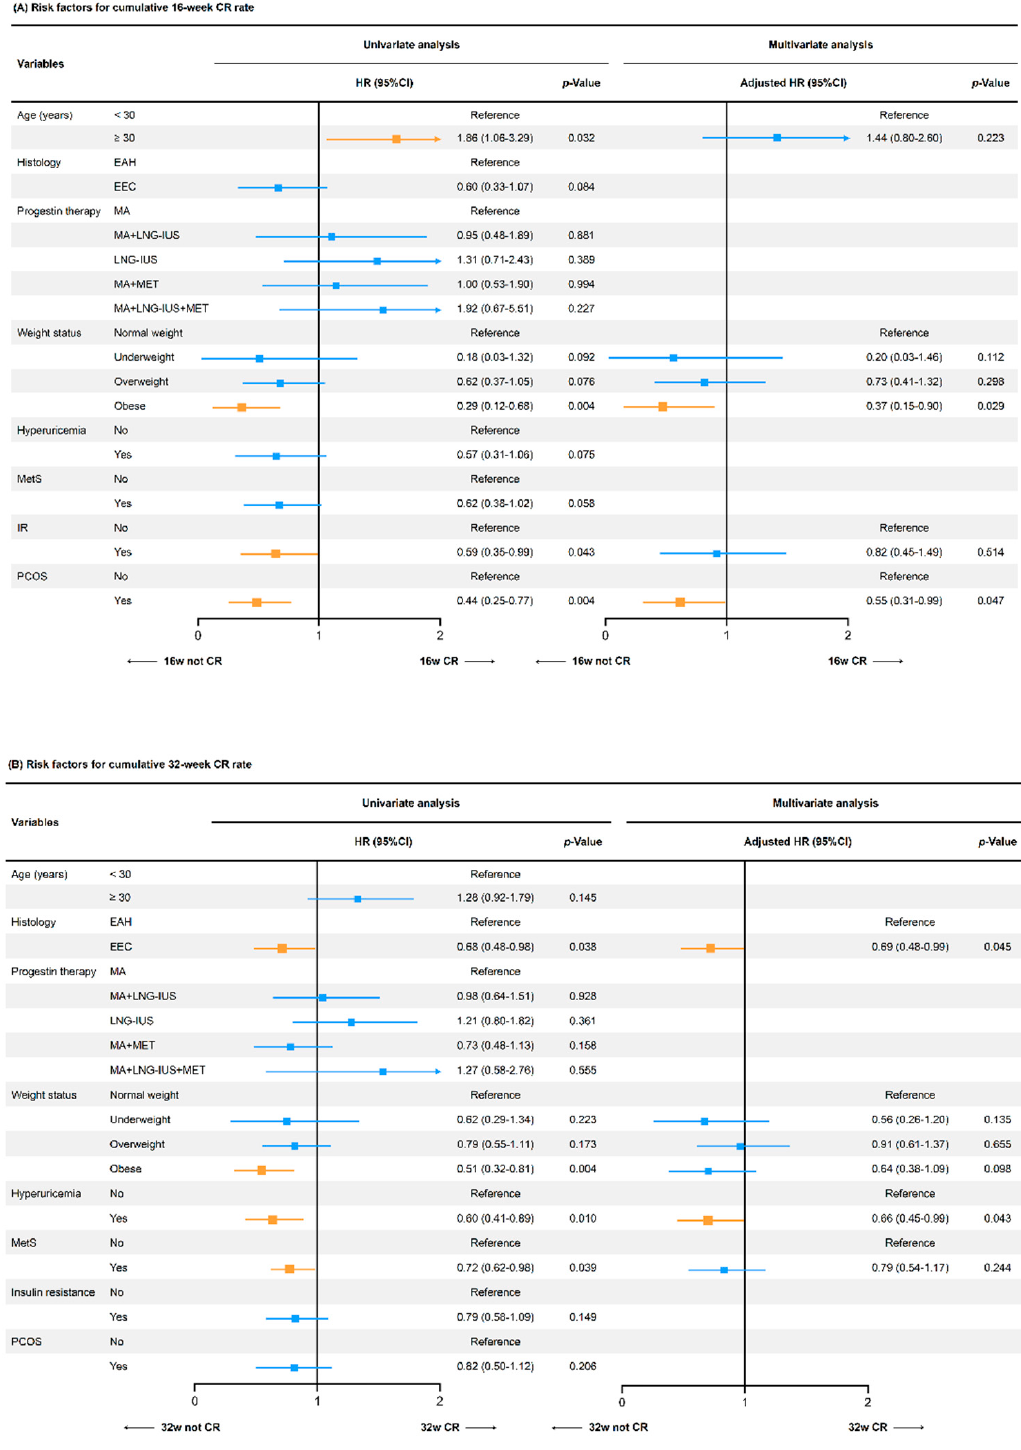
Figure 4. Risk factors associated with the cumulative CR rate at the 16th and 32nd week of treatment. ( A ) Risk factors for the cumulative 16-week CR rate; ( B ) Risk factors for the cumulative 32-week CR rate. The HR and 95%CI were evaluated by univariate or multivariate Cox regression analysis. MA, megestrol acetate; LNG-IUS, levonorgestrel intrauterine device; MET, metformin; IR, insulin resistance; MetS, metabolic syndrome; PCOS, polycystic ovary syndrome; HR, hazard ratio; CI, confidence interval.